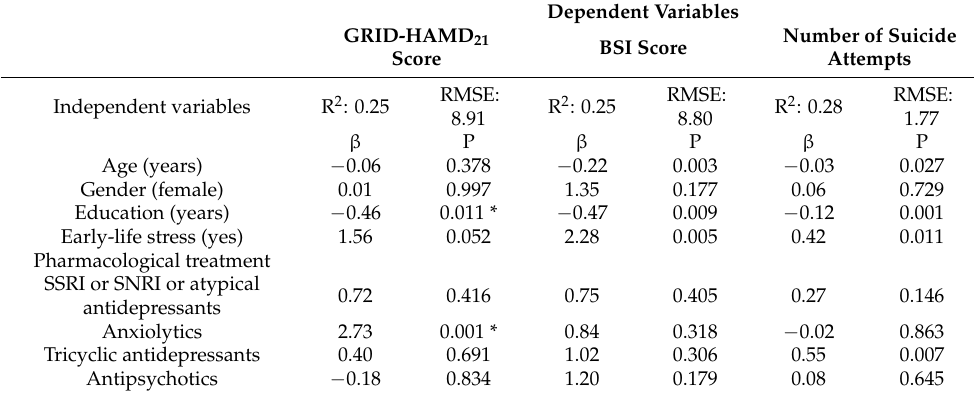
Table 2. Multivariate linear regression analysis showing the influence of genotypes and recessive model on GRID-HAMD 21 and BSI scores and number of suicide